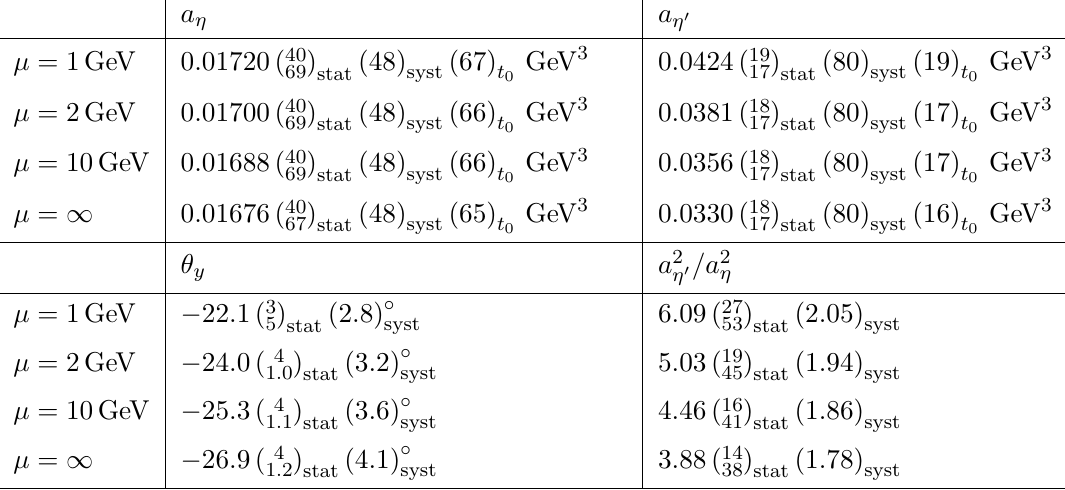
Table 19. Gluonic matrix elements of the η and η 0 and combinations thereof at various scales. lattice study of the pion and kaon masses and decay constants. Here, we quote the values presented in the FLAG review [109] for µ SU(3) = 0 . 770